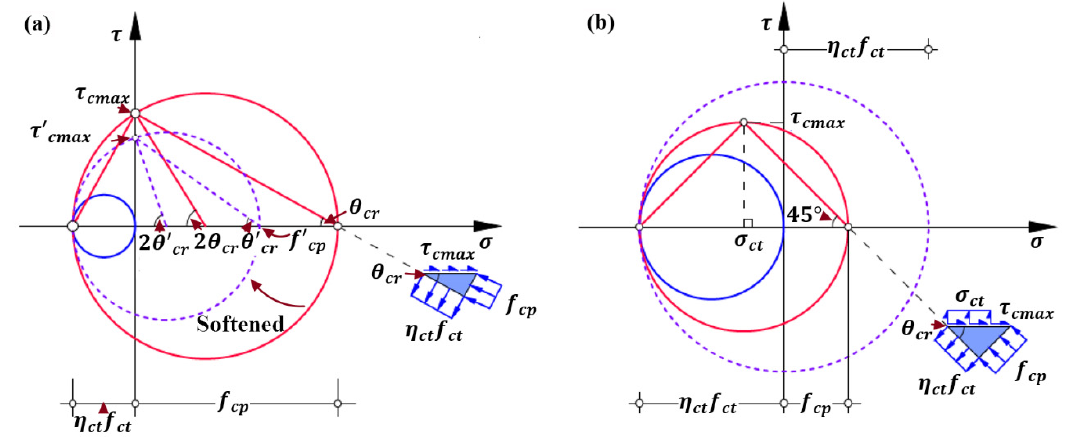
Figure 11. Mohr’s circle for the stress conditions of the micro concrete element at the end of FRP reinforcement: ( a ) Case 1; and ( b ) Case 2. reinforcement: ( a ) Case 1; and ( b ) Case